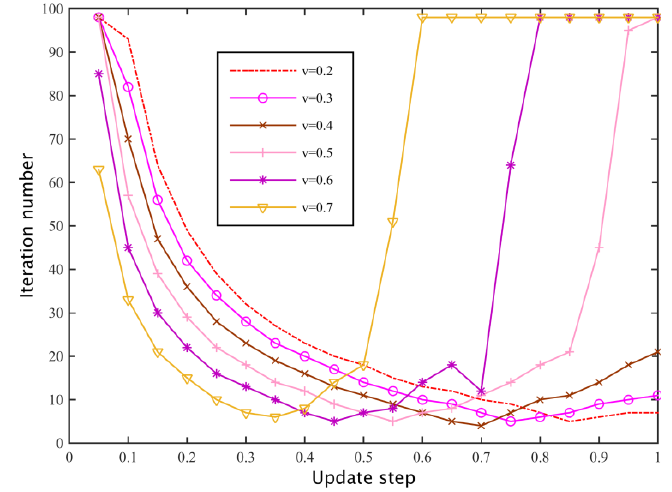
Figure 10. The relationship between the update step size and the number of iterations.